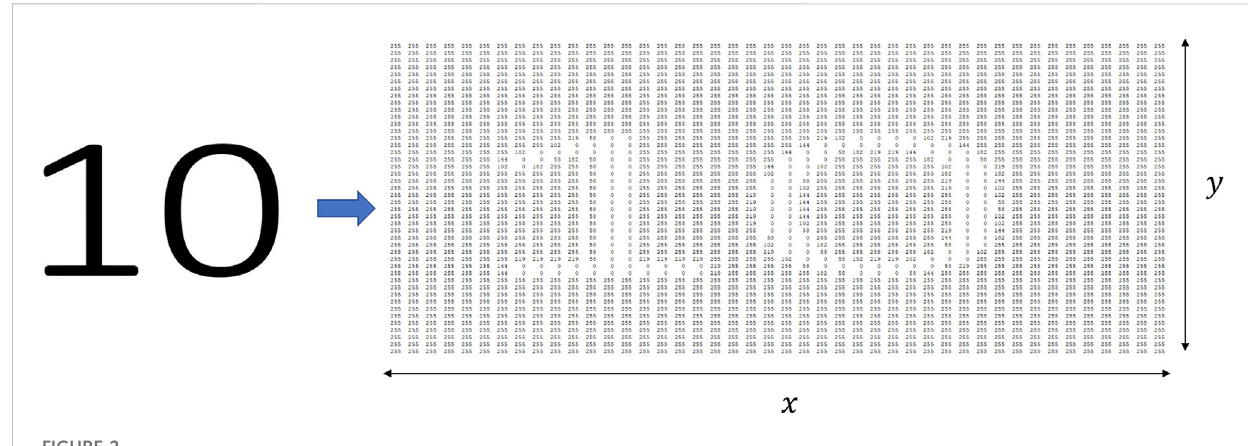
FIGURE 2 Image representation on